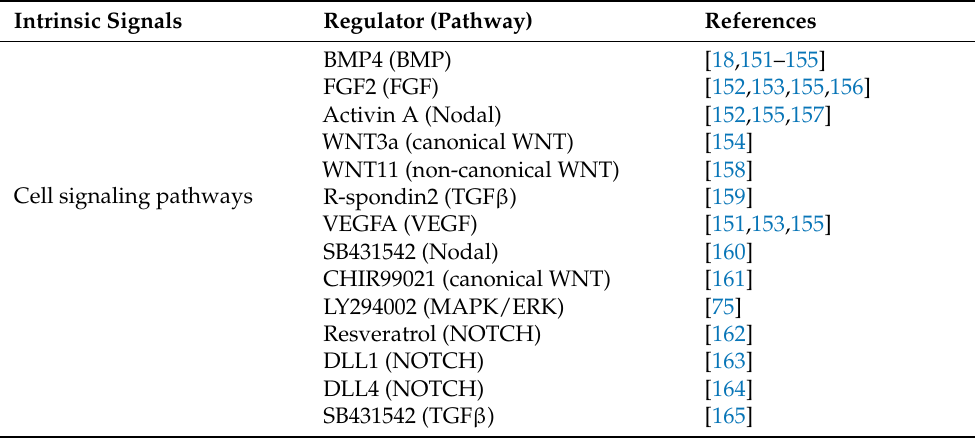
Table 1. Intrinsic cues for de novo generation of HSCs from human